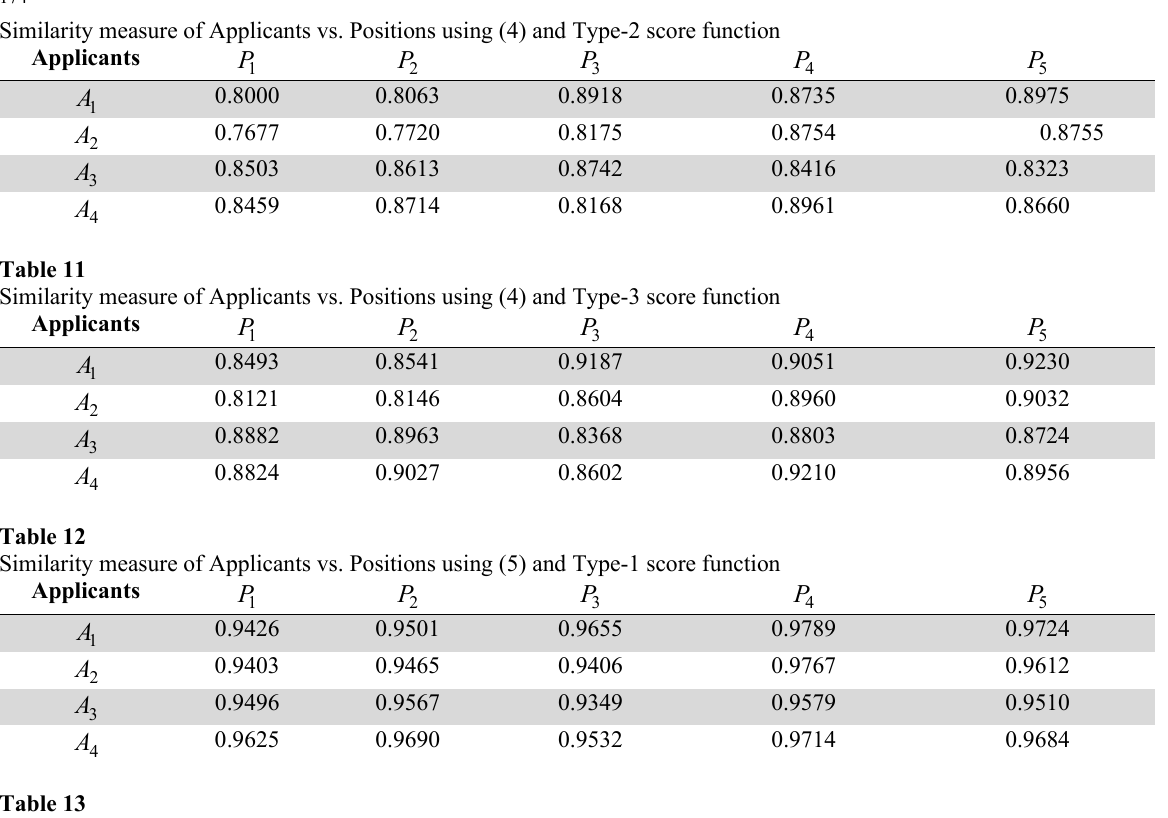
Similarity measure of Applicants vs. Positions using (5) and Type-2 score function